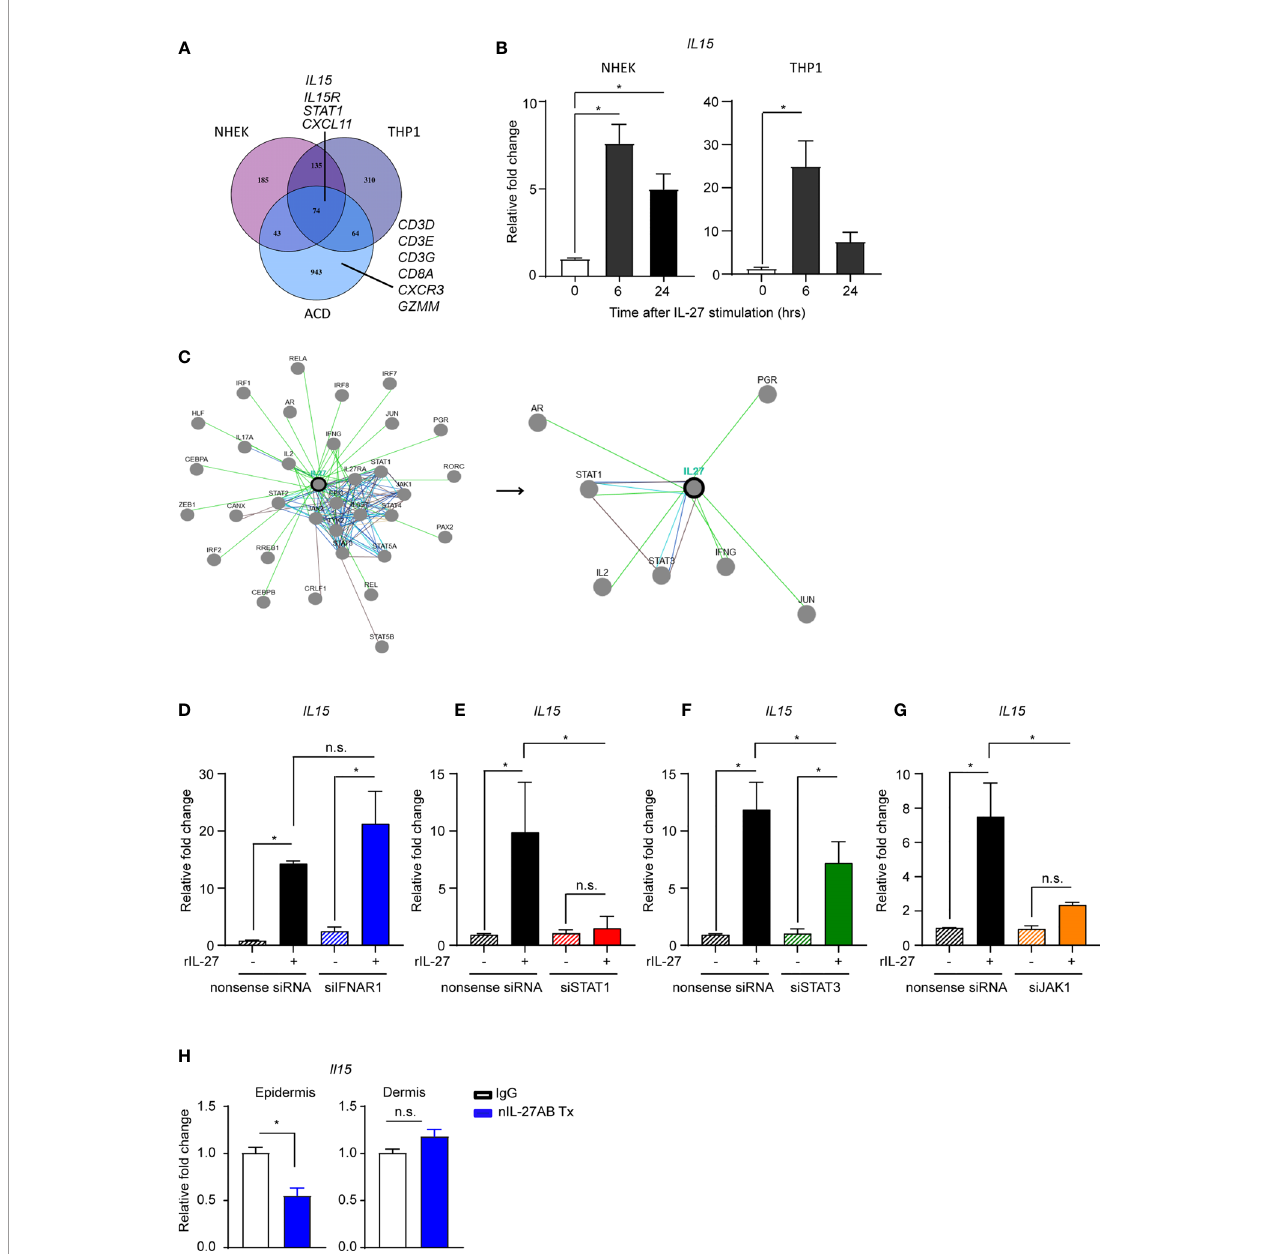
FIGURE 5 | IL-27 upregulates IL-15 production through a STAT1-dependent signaling pathway. (A) Overlap of genes that had a p-value ≤ 0.05 and at least a 50% increase in expression in each of the three datasets gene expression datasets. For the NHEK and THP-1 datasets, the 50% increase in expression was in the recombinant human IL-27 stimulated cells (rhIL-27, 100ng/ml). (B) Quantitative PCR of IL15 in NHEKs and THP1 stimulated with rhIL-27 (100 ng/ml). Data are summarized as mean ± SEM from at least 3 biological replicates, *p < 0.05 (ANOVA). (C) The biocomputational analysis from pathwaycommon ® representing the association pathways/molecules of IL-27 from open public data sets. (D – G) Quantitative PCR of IL15 in NHEKs transfected with siRNAs speci fi c for (D) IFNAR1, (E) STAT1, (F) STAT3, and (G) JAK1 expression and then stimulated with rhIL-27(100 ng/ml). Data are summarized as mean ± SEM from 1-2 biological replicates *p < 0.05; n.s., not signi fi cant (ANOVA). (H) Quantitative PCR of ll15 in the ear epidermis and dermis from the CHS murine model using DNFB hapten allergen (0.1% DNFB, applied topically every 1-2 months). The mice received nIL-27Ab (i.d.) 40 days after elicitation and the skins were harvested 6 hours later. Data are representative of at least 3 mice per group and summarized as mean ± SEM, *p < 0.05; n.s., not signi fi cant (unpaired Student ’ s t